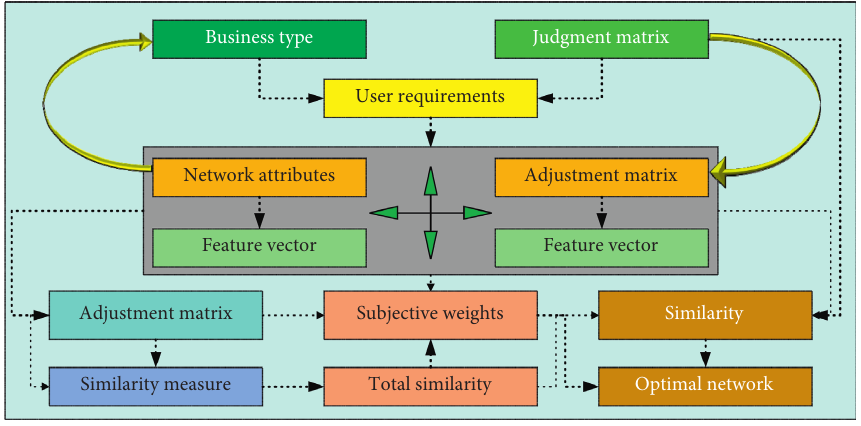
Figure 2: Algorithm